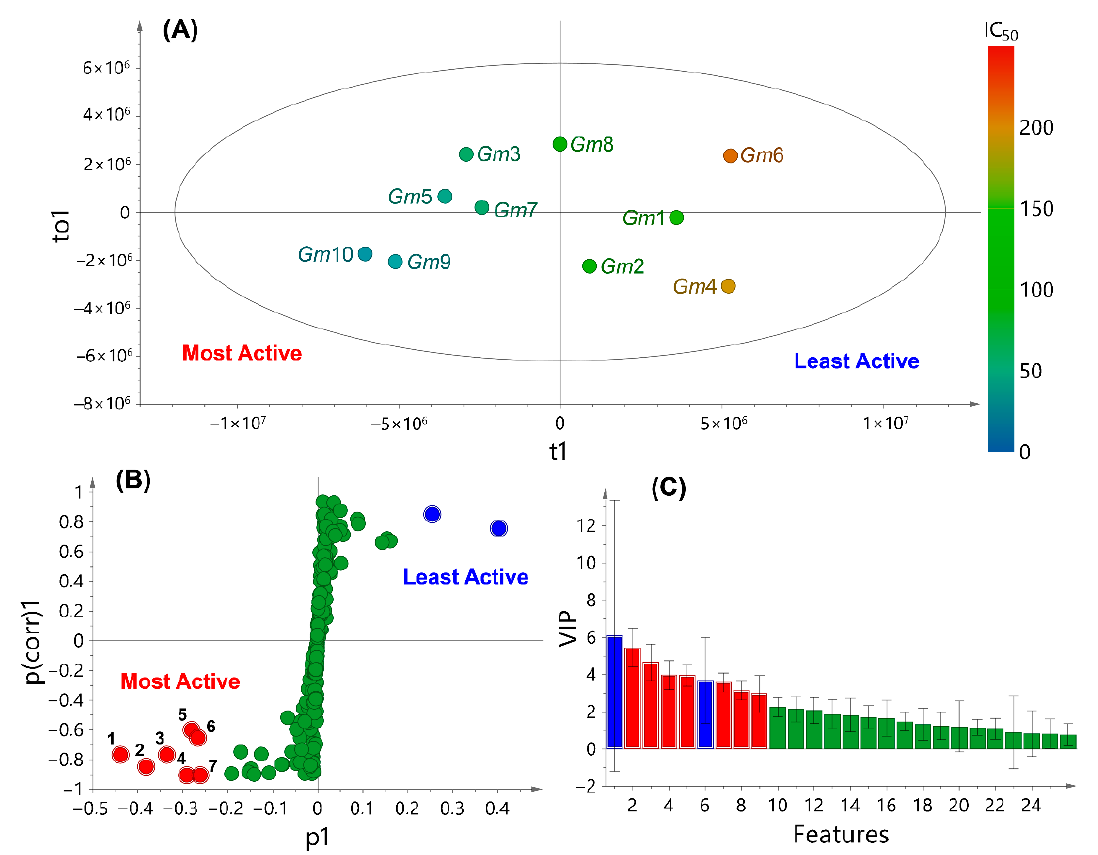
Figure 2. Integration of LC-MS-based fingerprints and anti-proliferative activity datasets of seed extracts from G. monspessulana accessions ( Gm 1–10) by single-Y orthogonal partial least squares (OPLS). IC 50 values were used as a continuous Y variable, depicted as a color scale (red = 250 µg/mL; blue = 0 µg/mL). ( A ) Score plot. ( B ) S-plot. ( C ) VIP plot. Red dots in the S-plot, numbered as 1–7 , indicate the most influential variables.